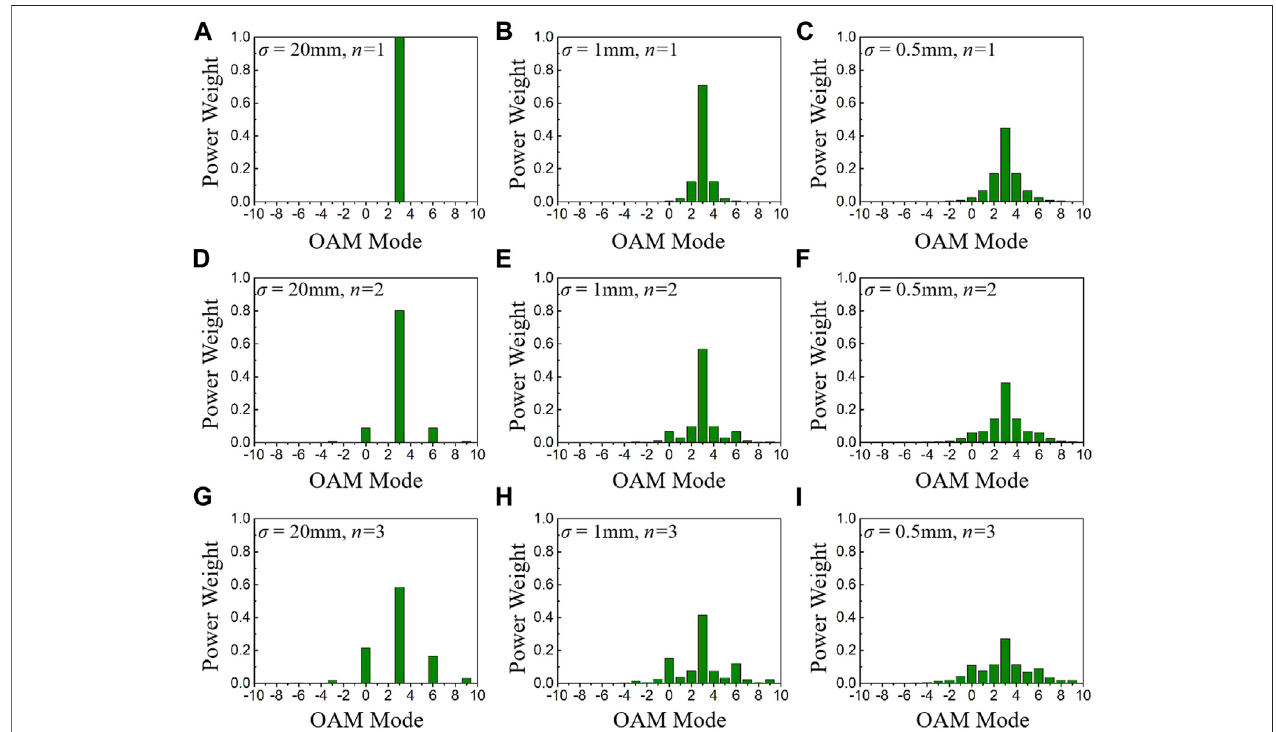
FIGURE2| OAMspectrumofthePC-PEPVbeamwithbeamwaist w 0 (cid:1) 1 mmandTC m (cid:1) 3,underdifferentspatialcoherence σ andpowerorder n . (A – C) σ (cid:1) 20, 1, 0.5 mm, and power order n (cid:1) 1; (D – F) σ (cid:1) 20, 1, 0.5 mm, and power order n (cid:1) 2; and (G – I) σ (cid:1) 20, 1, 0.5 mm, and power order n (cid:1) 3.